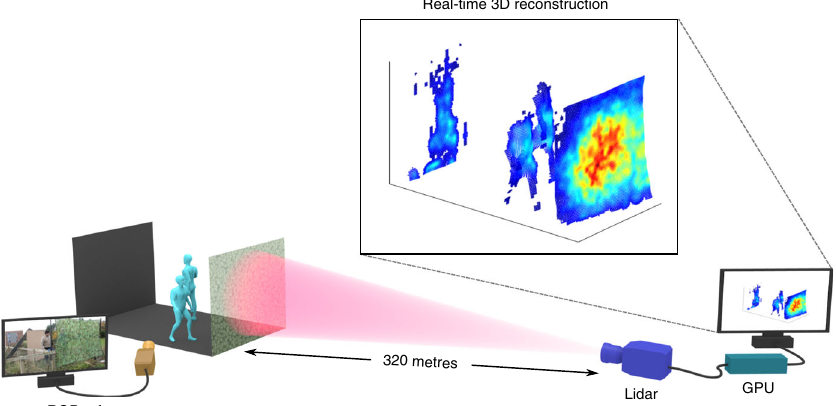
Fig. 4 Schematic of the 3D imaging experiment. The scene consists of two people walking behind a camou fl age net at a stand-off distance of 320 metres from the lidar system. An RGB camera was positioned a few metres from the 3D scene and used to acquire a reference video. The proposed algorithm is able to provide real-time 3D reconstructions using a GPU. As the lidar presents only N N resolution of N 96 pixels (Supplementary r ¼ c ¼